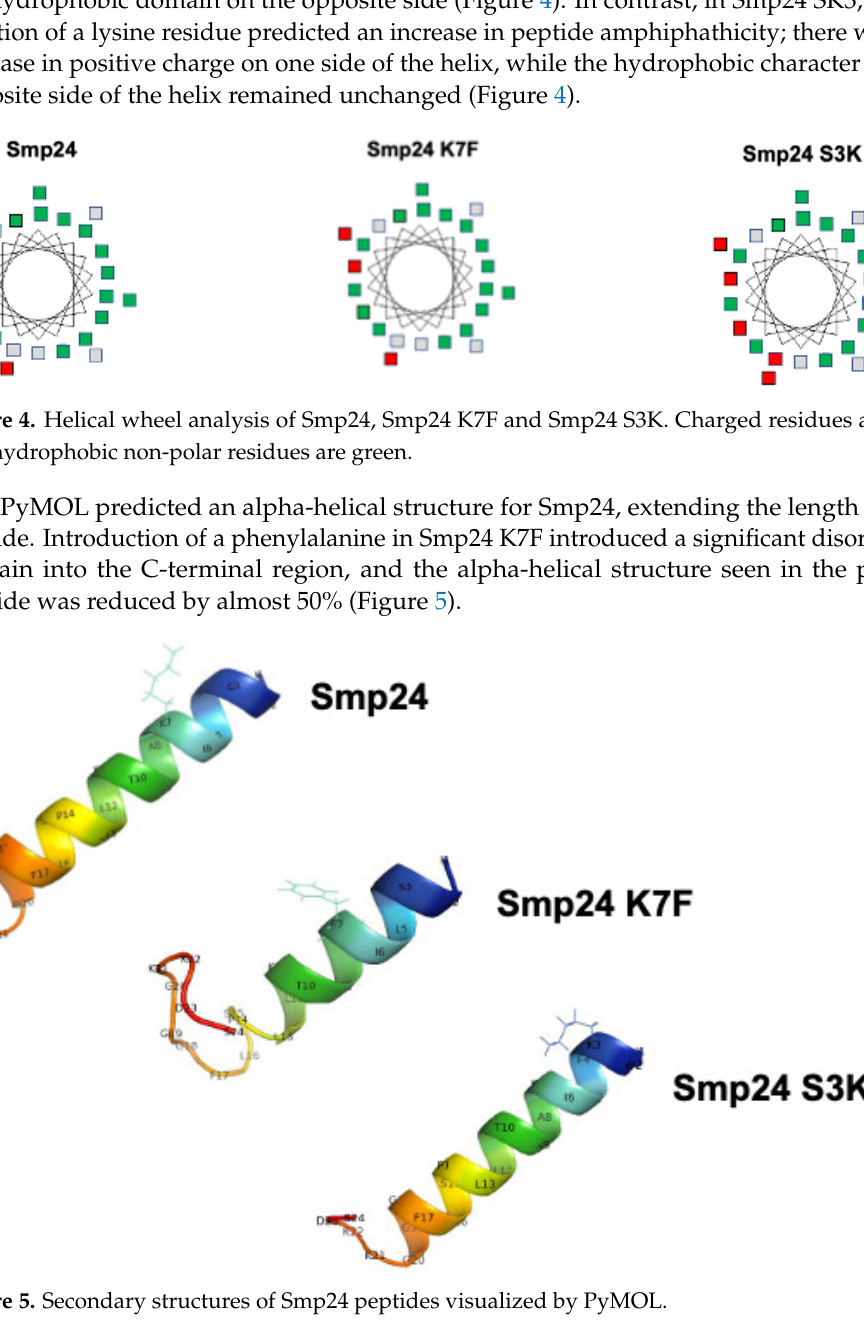
Figure 6. Space filling models of Smp24 and Smp24 derived peptides. Polar facets are highlighted in blue and non-polar facets are highlighted in red, using the HM calculator [28].